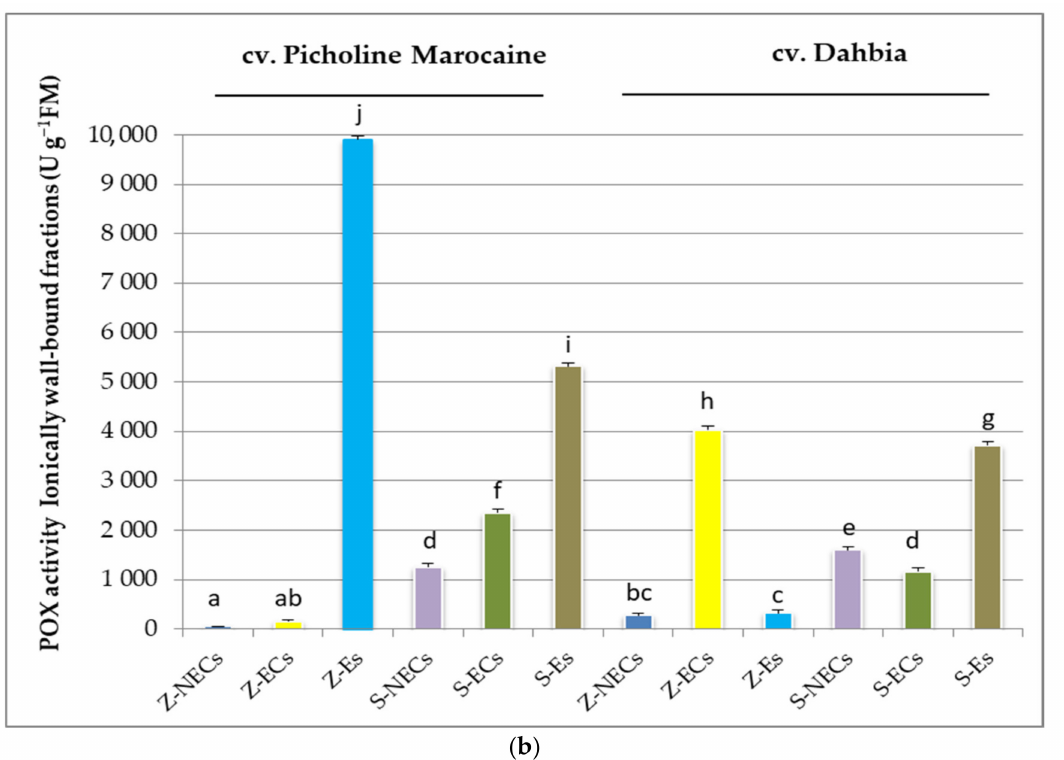
Figure 2. Peroxidases (POXs) activities expressed as units per gram of fresh matter (U g − 1 FM) tested in soluble enzyme fractions ( a ) and ionically wall-bound fractions ( b ) extracted from the nonembryogenic calluses (NECs), embryogenic calluses (ECs), and somatic embryos (Es) derived from the zygotic and somatic explants of the olive cvs. Picholine Marocaine and Dahbia. Z and S refer to zygotic and somatic origins, respectively. The values refer to means of the three biological extractions. Values (mean ± SE) with different letters (a,b,c, . . . ) are significantly different ( p < 0.05), according to the Student–Newman–Keuls (SNK)